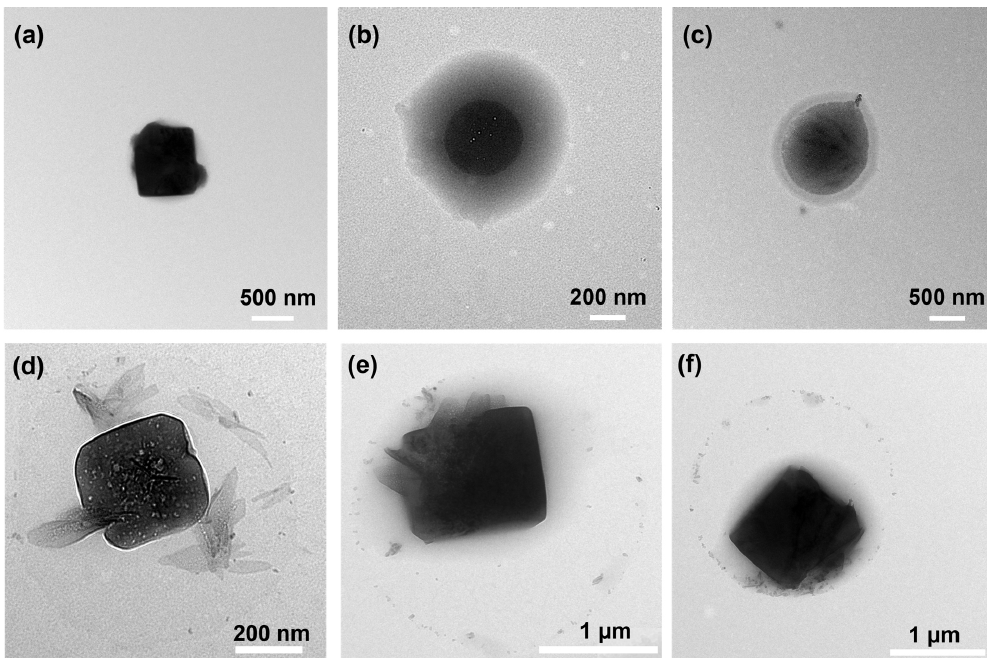
Figure 7. TEM images of morphology identified for sea spray aerosols produced from (a) natural seawater, (b) seawater with glucose, and (c) seawater with trehalose without fatty acids organic layer, (d) natural seawater with fatty acids, (e) seawater with glucose and fatty acids, and (f) seawater with trehalose and fatty